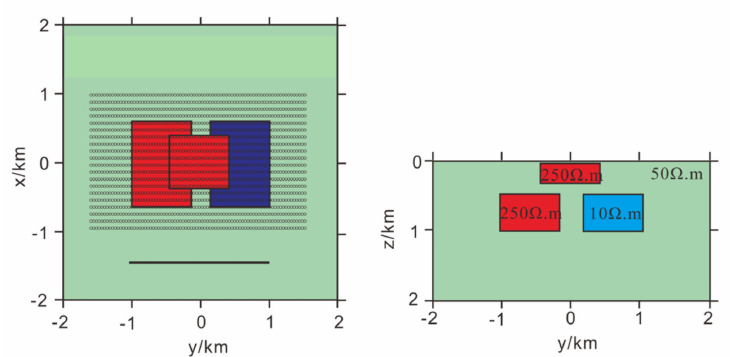
Figure 7. Schematic diagrams of the transceiver and the locations of the anomalies.